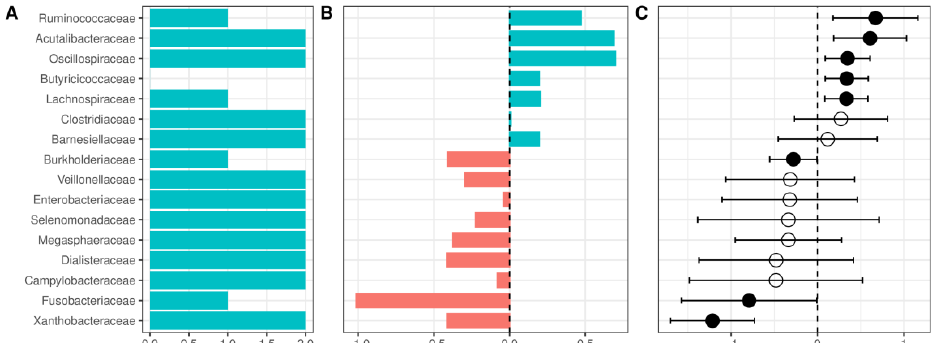
Figure 6. Changes in the relative abundance between patients with alcohol use disorder and healthy controls at the family level. ( A ) Number of datasets in which the given family was detected as significant. ( B ) Change in the relative abundance of a given family in the combined dataset reported as log-ratio. Blue denotes bacteria more abundant in healthy controls, and red more abundant in alcohol use disorder. ( C ) Change in the relative abundance of a given family after summarizing results from individual datasets using the random-effects model, expressed as a mean difference in centered log ratios. Values larger than zero denote greater abundance in healthy controls. A full dot denotes a statistically significant effect. Error bars indicate 95% confidence intervals. Only bacteria detected as significant in at least two datasets or significant in the random-effects analysis are presented.